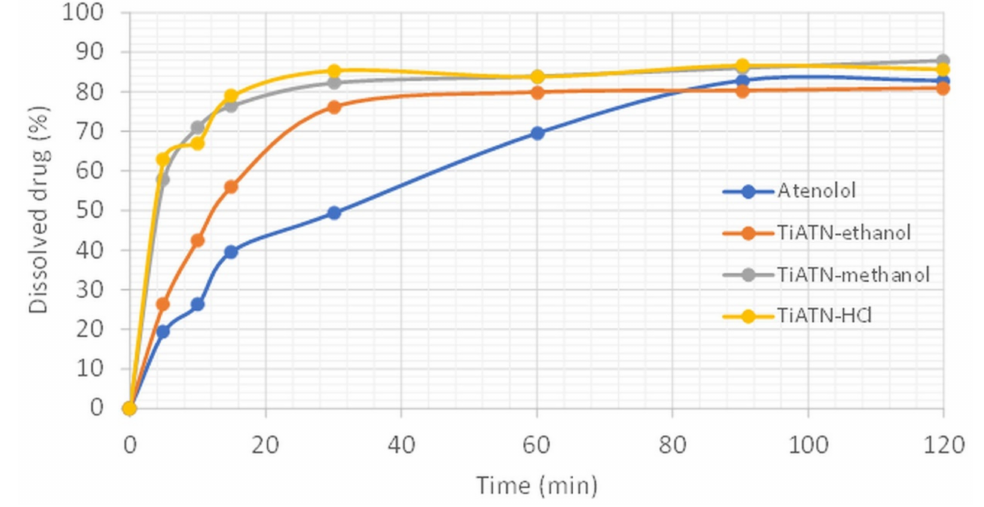
Figure 6. Dissolution study of TiATN composites in gastric juice (non-sink